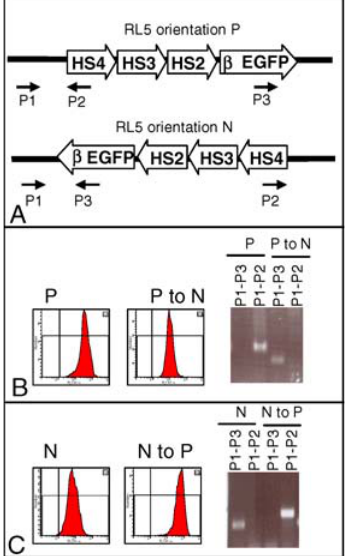
Figure 5. Cre Recombination Per Se Does Not Lead to Silencing Cells containing cassette 234- b -EGFP at RL5 were transfected with the Cre recombinase, and inverted sub-clones were identified using primer pairs p1/p2 (specific for the P orientation) and p1/p3 (specific for the N orientation). (A) Location of the primers used to identify the inverted clones. (B) P to N inversion: The histogram on the left illustrates expression profile of a clone with insertion in the P orientation before inversion. The histogram on the right illustrates expression 8 wk post-inversion. The ethidium bromide stain illustrates the PCR analysis demonstrating the inversion. (C) Same as (B) but for the N to P inversion. This analysis clearly demonstrates that Cre recombination per se does not lead to silencing (see text). As reported previously, levels of expression in the N orientation at RL5 are lower than in the P orientation [32]. N, non-permissive orientation; P, permissive orientation. DOI: